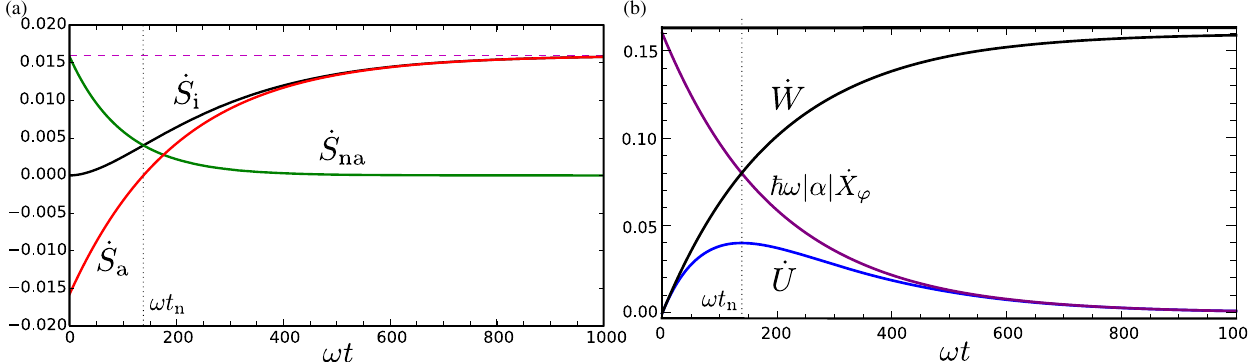
_ _ _ S S S FIG. 7. Time evolution of (a) adiabatic ( ), nonadiabatic ( ), and total ( ) entropy production rates represented by solid lines, and a na i _ W _ U (b) input power ( ), rate at which the cavity mode absorbs energy ( ), and displacement rate ( equilibrium with the thermal reservoir, ρ 0 ¼ e − β ˆ H 0 Z , and the laser driving is switched on at t ¼ 0 . The dashed line in (a) corresponds to β _ W , and we use vertical dotted lines to highlight the instant of time at which the adiabatic entropy production rate changes its sign ( t ss We use parameters ϵ ¼ 0 . 02 ω , γ 0 ¼ 0 . 01 ω , and temperature kT ¼ 10 ℏ ω , for ℏ ω ¼ 1